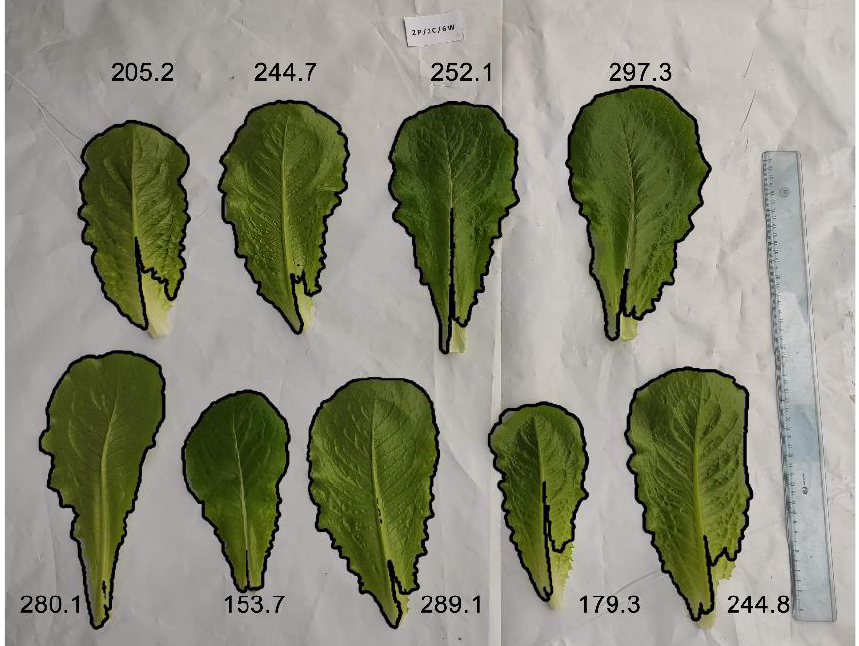
Figure 3. Processing of a leaf samples with ImageJ. Leaf areas are enveloped in black solid lines and area values are denoted in cm 2 . Treatment name in the photograph includes 2P to denote perlite fraction.